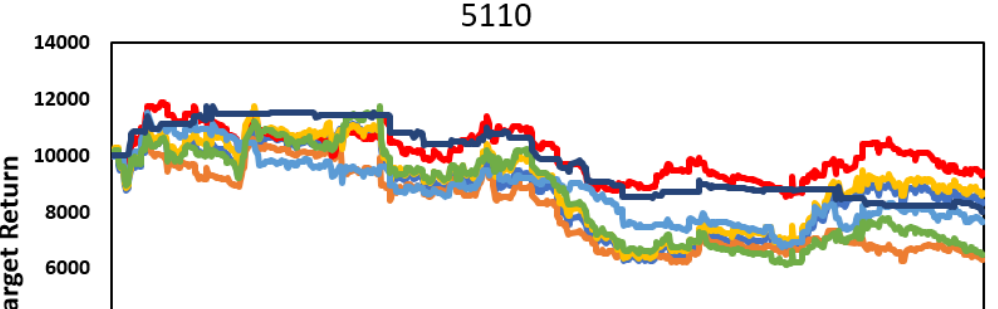
Figure 18. Outcome of 7010 stock target return during model training with different reward functions (Initial portfolio value $10,000).